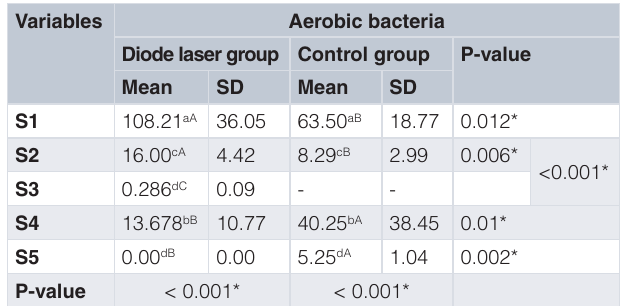
Table 4. Mean and standard deviation values of the bacterial count (CFU/ml ×10 4 ) of aerobic bacteria of different groups.